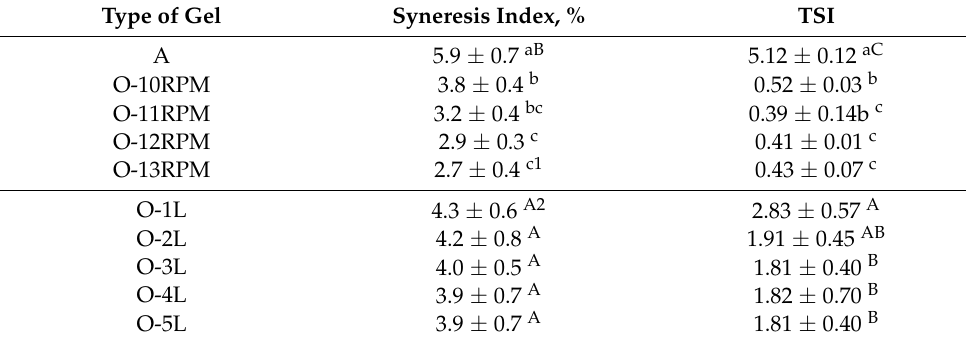
Table 4. Syneresis index and TSI value of gels with